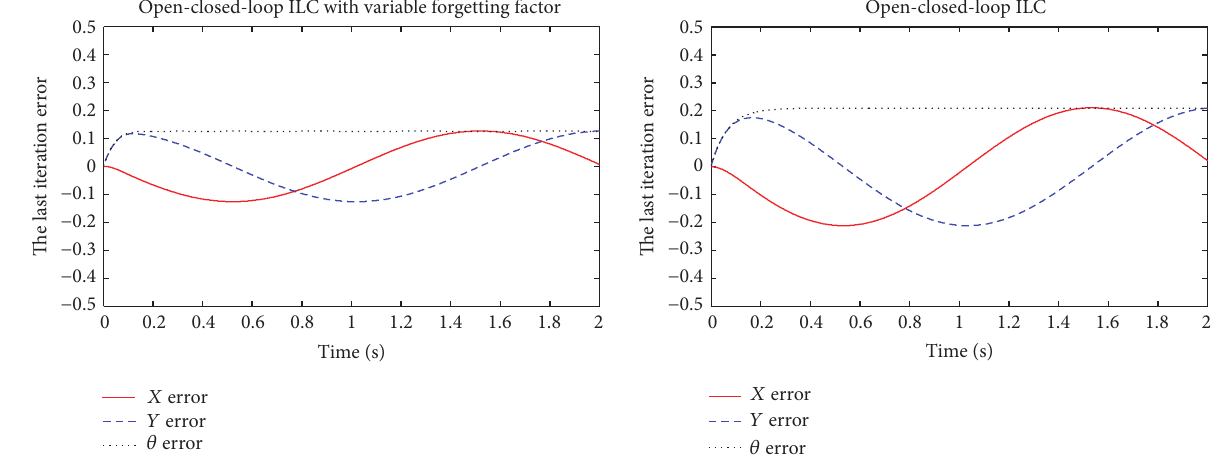
Figure 4: Tracking error in the last